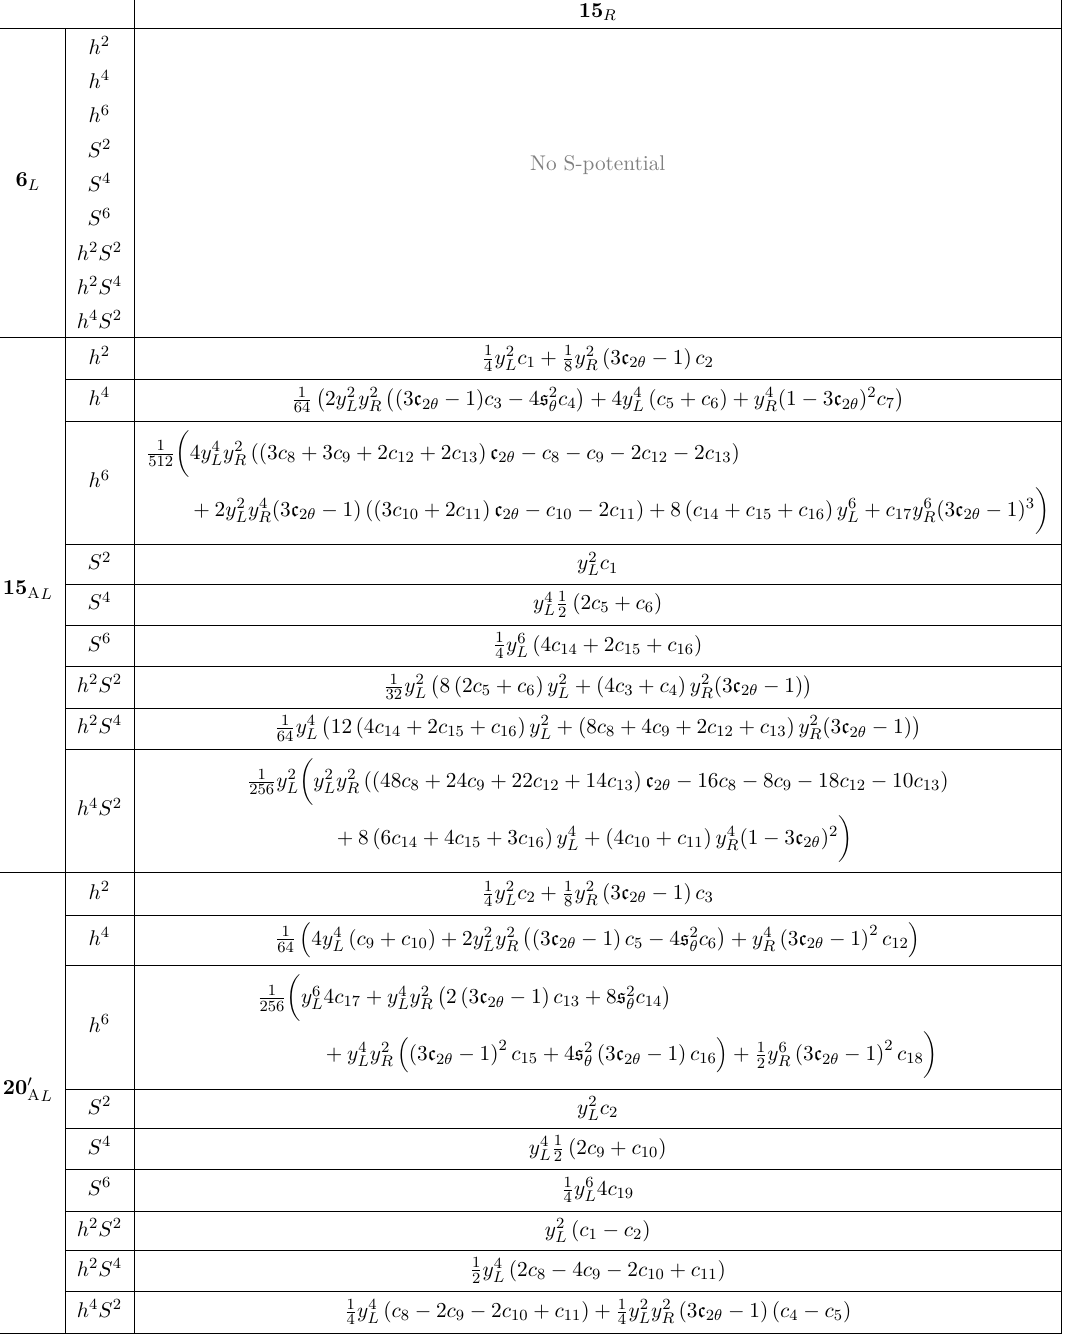
Table 3 . V ( h, S ) terms obtained via our spurion analysis for t R in a 15 of SO(6) . Only leading terms are shown and each entry should be multiplied by N c m 4 a factor 1 /f and every y L,R with a 1 /g ∗ . Parameters that contribute in the same way in the given approximation were collected into single c i and we abbreviate c 2 θ = cos 2 θ 15R and s 2 while the other angle is set to zero, respectively. As discussed in the text, going to finite values of the displayed angle changes the hierarchy of terms for the 20 0 L